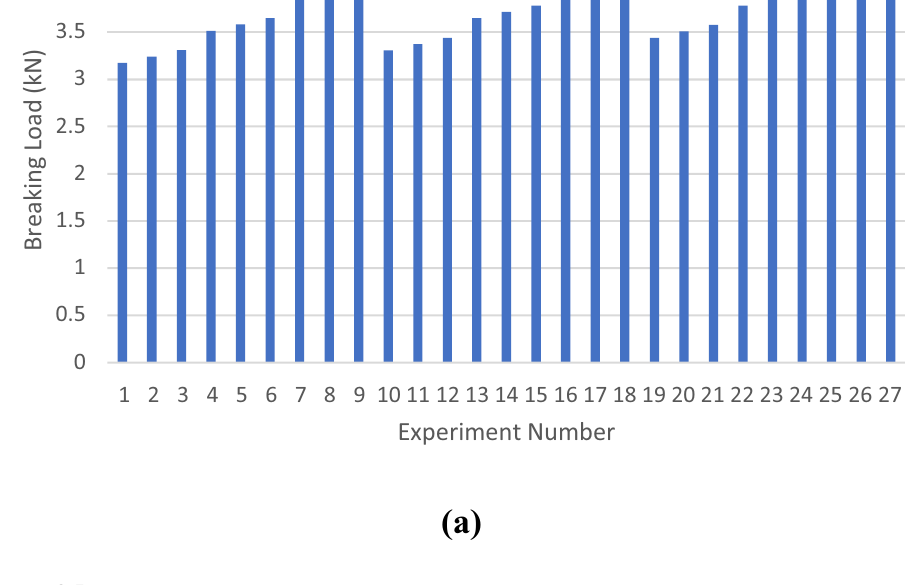
Fig. 5 Breaking load for a Bare Sheets b Copper Interlayer c SS Interlayer d